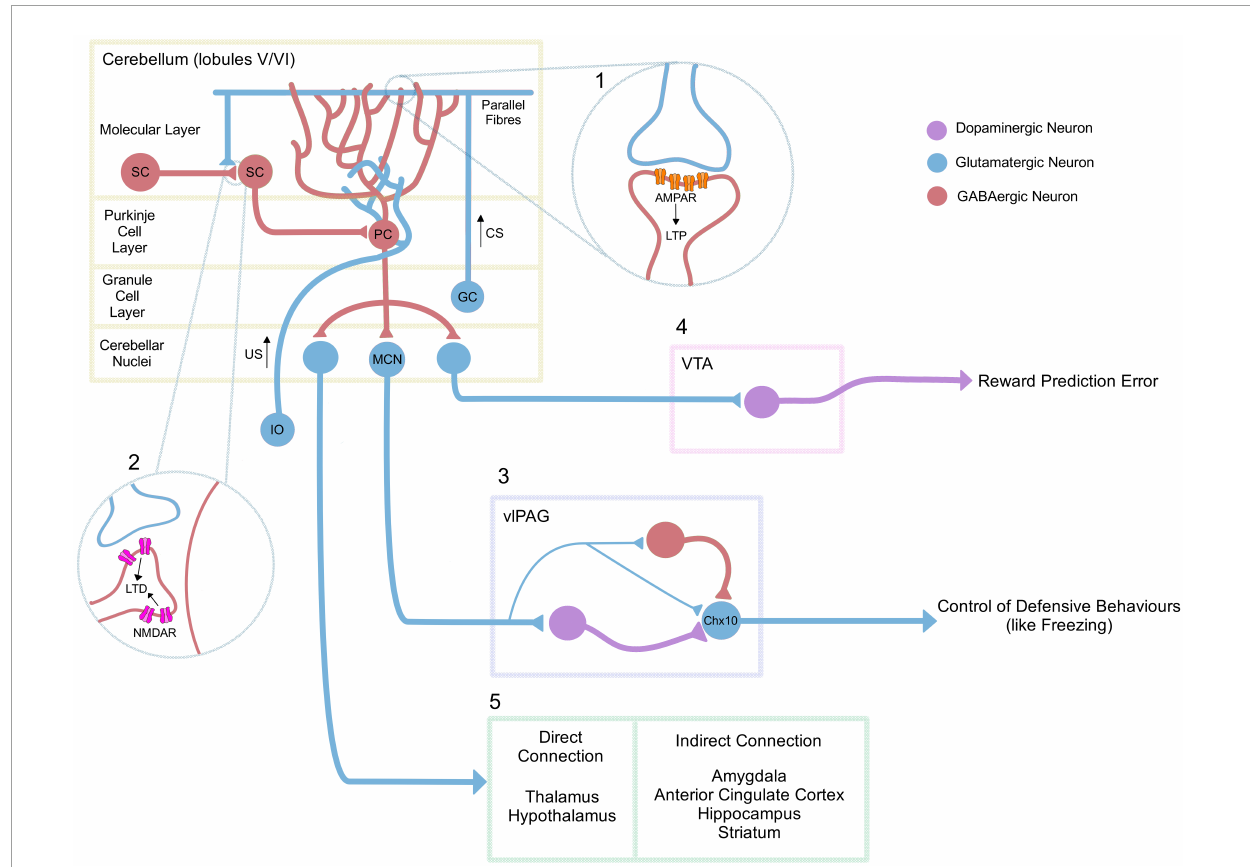
FIGURE1 Neurocircuitry underlying adaptive cerebellar fear processes. In classical pavlovian conditioning, the inferior olive (IO) signals the US, while the mossy fibre-parallel fibre pathway (MF-PF) signals the unconditional stimulus. (1) During the acquisition of a fear memory, there is an upregulation of AMPA receptors at the PF-PC synapse, resulting in post-synaptic long-term potentiation (LTP; Sacchetti et al., 2004; Zhu et al., 2007), as well as an increase of GABAergic signalling onto Purkinje cells from molecular layer interneurons/stellate cells (SC) (Scelfo et al., 2008). Various cerebellar lobules in rodents have been associated with fear learning, but the underlying mechanisms relating to LTP have focused primarily on lobules V/VI. (2) In contrast, NMDAR-mediated long-term depression (LTD) at SC-SC synapses has been associated with extinction (Dubois and Liu, 2021). (3) The medial cerebellar nuclei (MCN) have also been directly associated with fear extinction (Frontera et al., 2020), via projections to dopaminergic, GABAergic and glutamatergic neurons in the vlPAG, Vaaga et al. (2020). MCN projections are capable of modulating glutamatergic neurons that express the transcription factor Chx10 in the vlPAG (Vaaga et al., 2020) which have previously been associated with freezing behaviour through their projection to the magnocellular reticular nucleus. This in turn is directly connected to motor neurons of the spinal cord (Tovote et al., 2016). (4) The cerebellar nuclei also project to the VTA; an area associated with the enhancement of fear extinction learning (Carta et al., 2019). (5) Finally, the cerebellum also projects either directly (thalamus, hypothalamus) or indirectly (amygdala, anterior cingulate cortex, hippocampus, striatum) to multiple other areas that could be related to the fear network (Apps and Strata, 2015). PC: Purkinje Cell, MCN: Medial Cerebellar Nuclei, SC: Stellate Cell, GC: Granule Cell, CS: Conditioned Stimulus, US: Unconditioned Stimulus, VTA: Ventral Tegmental Area, vlPAG: VentroLateral PeriAqueductal